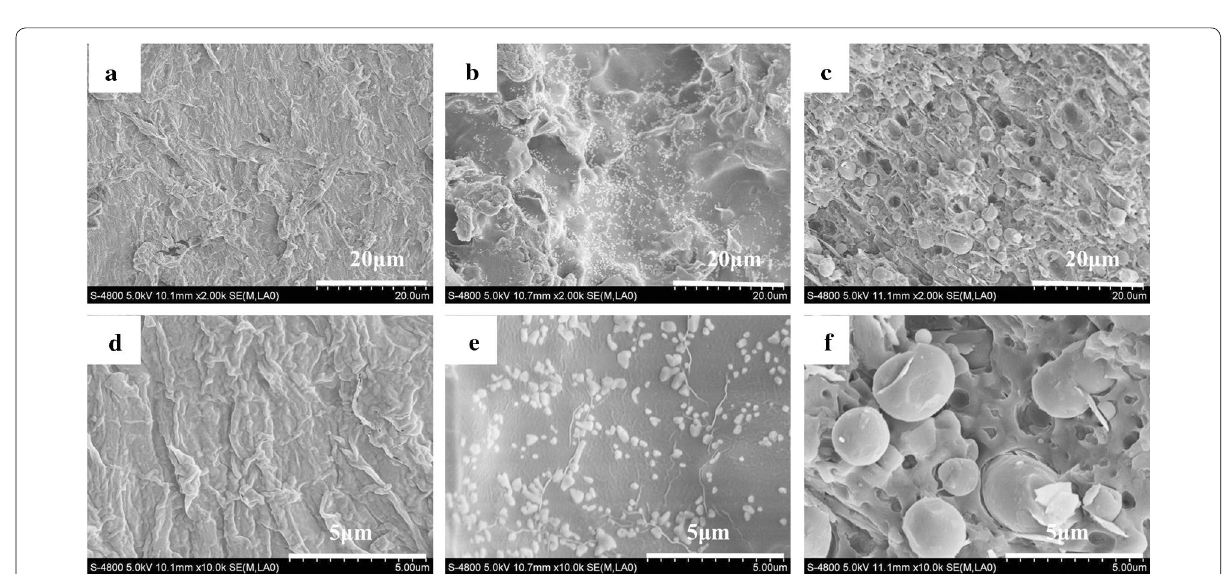
Fig. 4 SEM morphologies of the freeze‑fractured surface of pure PP 2000 2000 ( c ) and pure PP 10,000 ×